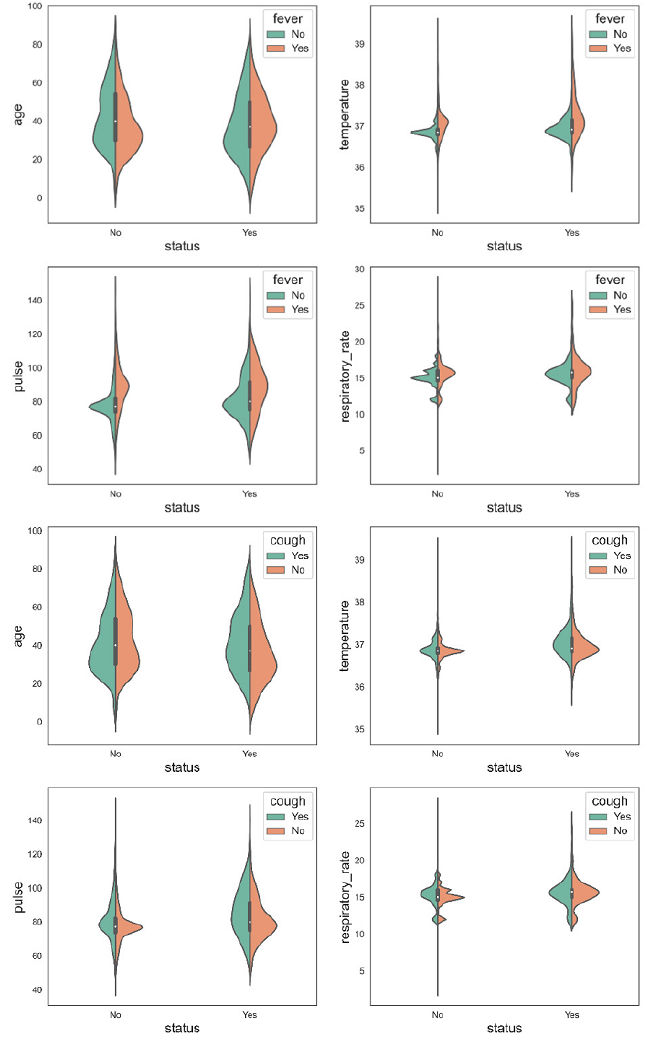
Figure 8. Violin plot of data distribution in terms of fever and